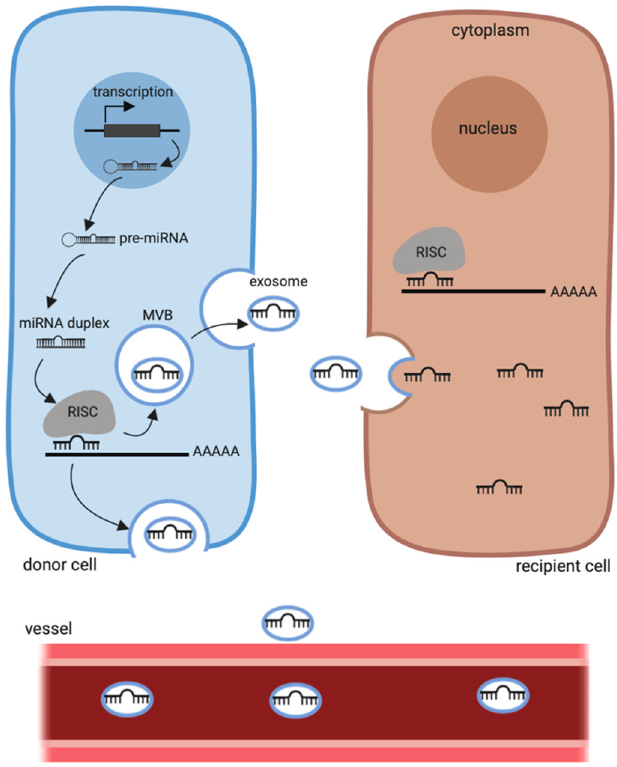
Figure 3. miRNA biogenesis pathway. miRNA is transcribed in the nucleus and then cleaved numerous times to conduct to a mature single strand miRNA included in the RISC complex. miRNA may regulate gene expression in the cell but also in other cells by their encapsulation in microvesicles such as exosomes. miRNA may also be disseminated through the bloodstream. MVB: endosomal MultiVesicular bodies, RISC: RNA-induced silencing